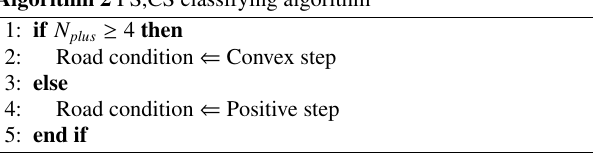
Algorithm 2 PS,CS classifying